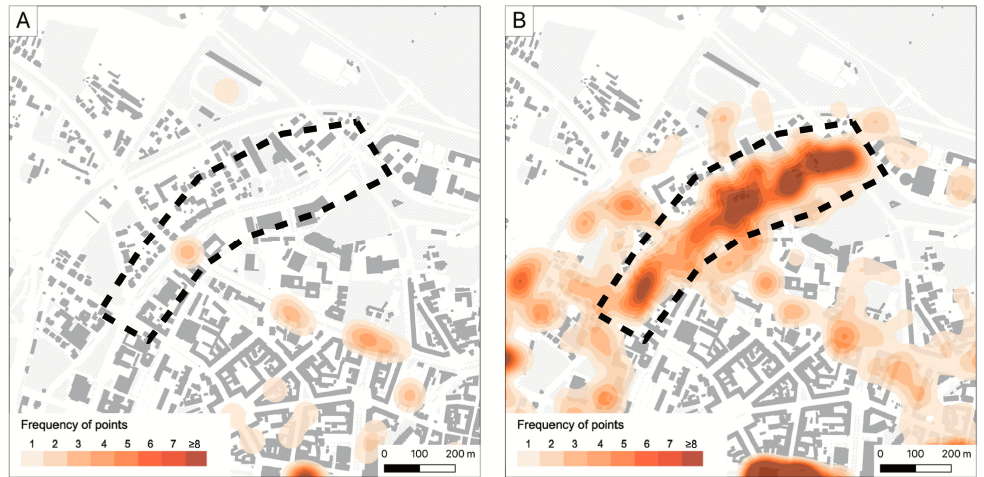
Figure 8. Comparison of places indicated by the group of residents ( A ) and urban planners ( B ) regarding noisy areas—Old Town bypass road—Niepodległo´sci Avenue. The dashed black line marks the areas of difference. Source of reference data: © OpenStreetMap contributors, see: https://www.openstreetmap.org/copyright (accessed 10 February